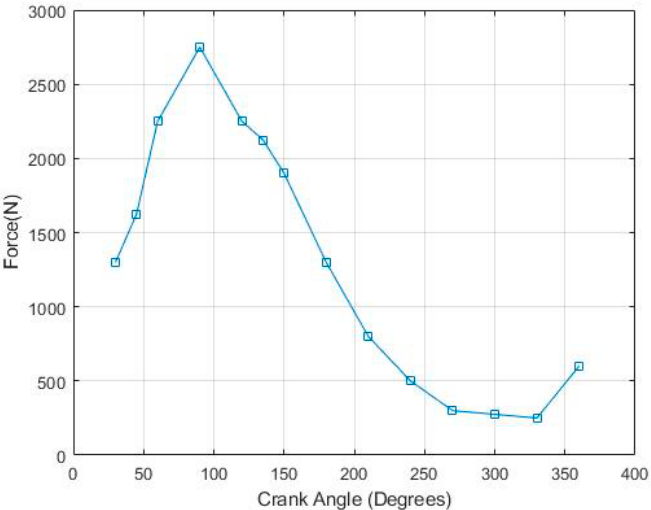
Figure 4. Cycling dynamics.